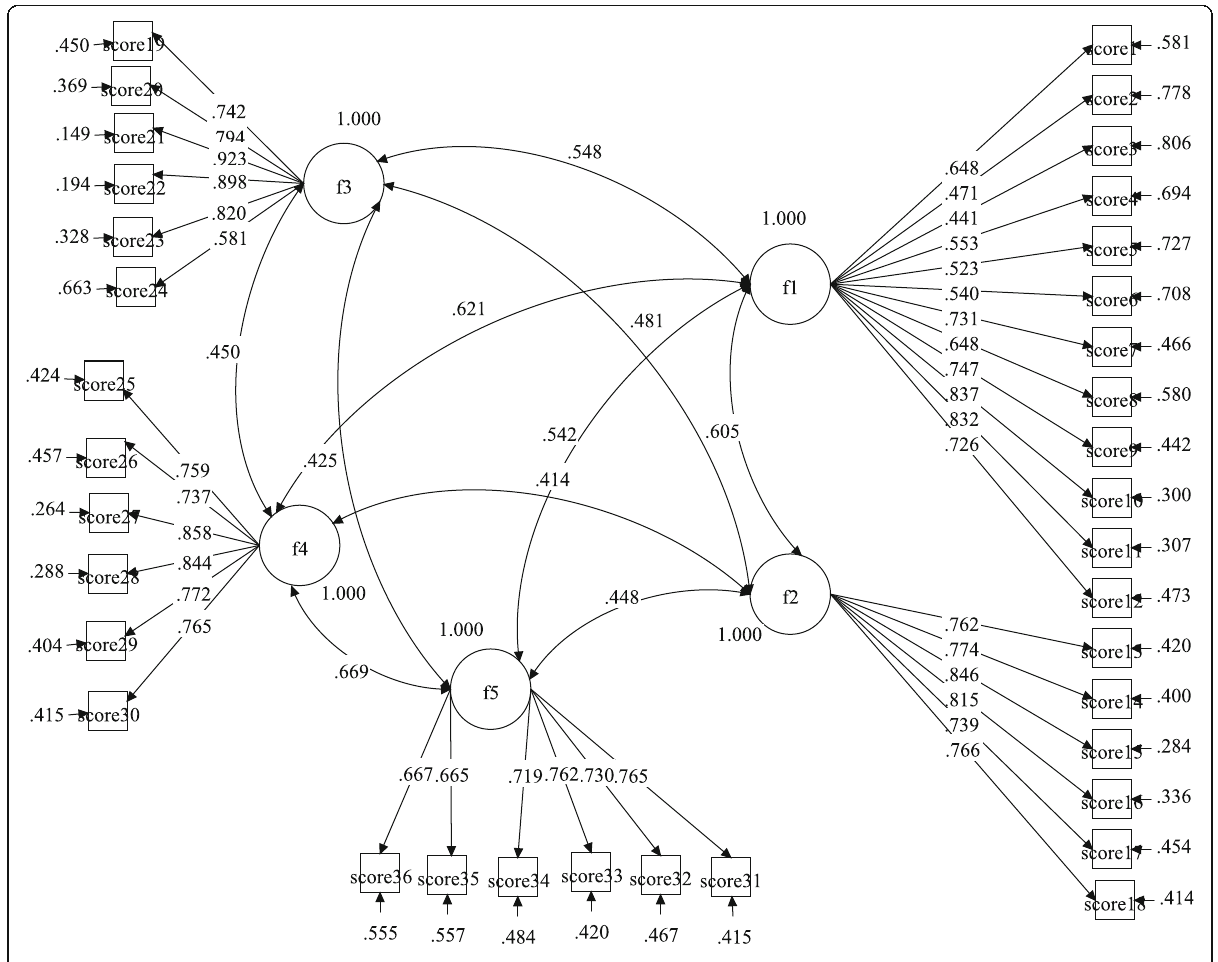
Fig. 1 Five-factor implicit structure established with CFA by